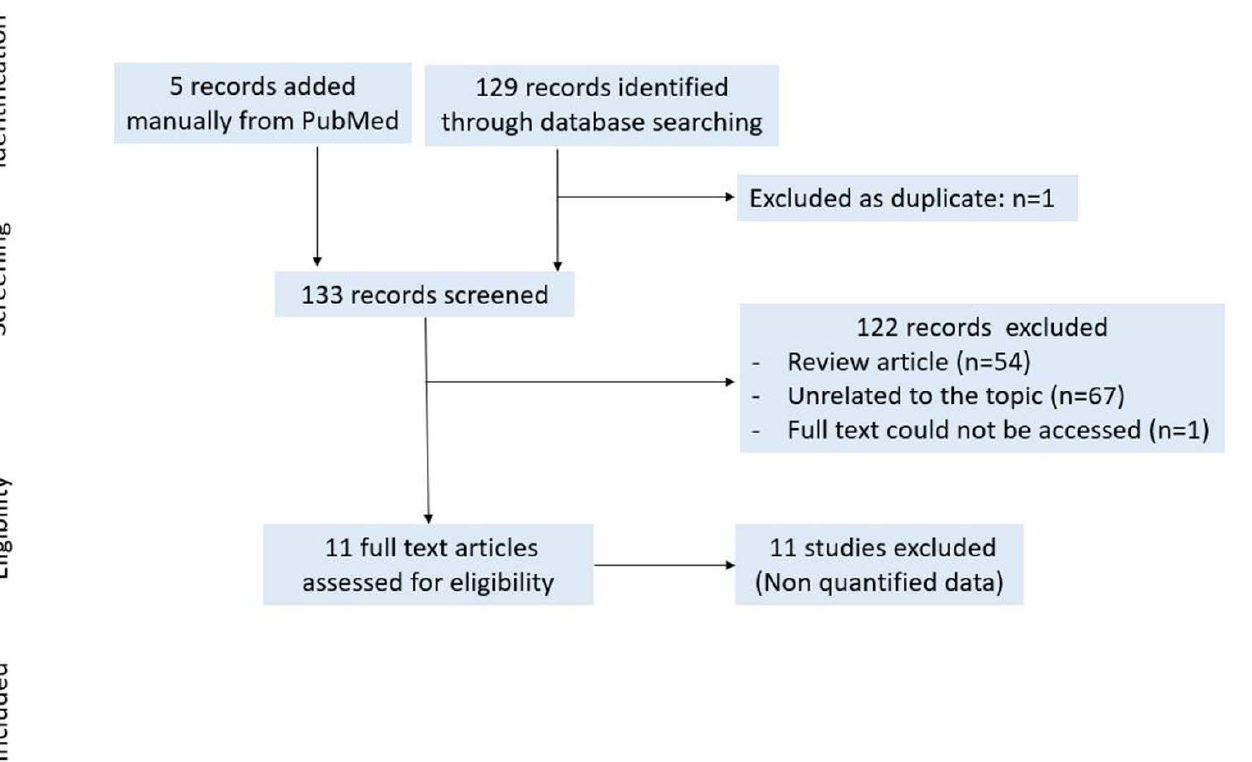
Figure 9. Study selection for histone modifications.